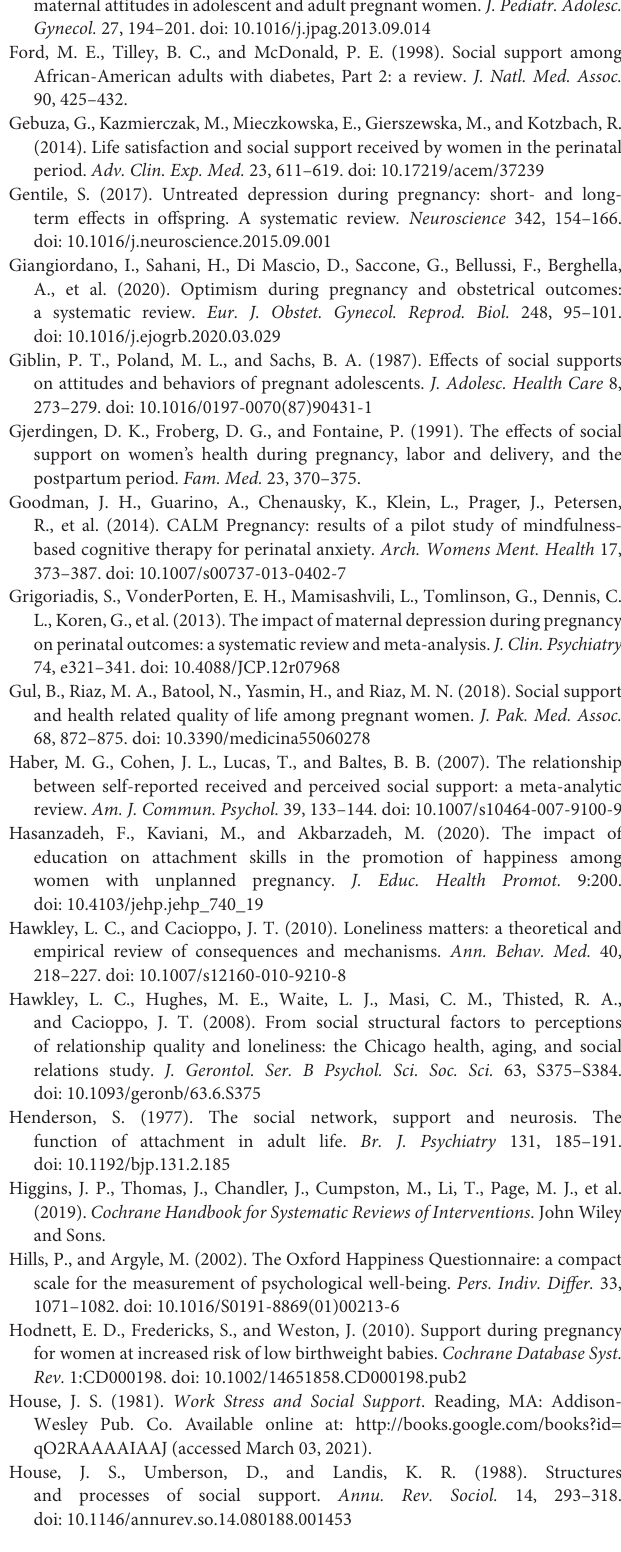
Figueiredo, B., Tendais, I., and Dias, C. C. (2014). Maternal adjustment and maternal attitudes in adolescent and adult pregnant women. J. Pediatr.